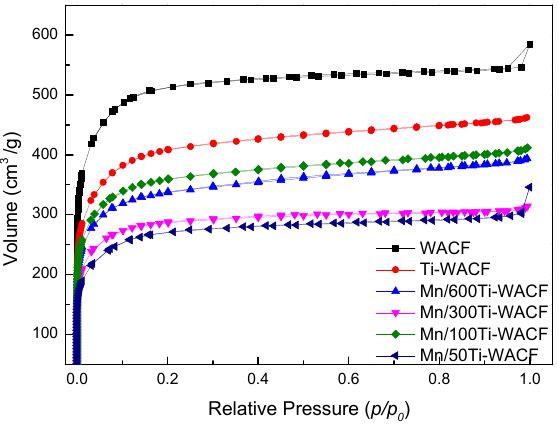
Figure 4. N 2 adsorption/desorption isotherm of WACF and Mn/TiO 2 –WACF samples.